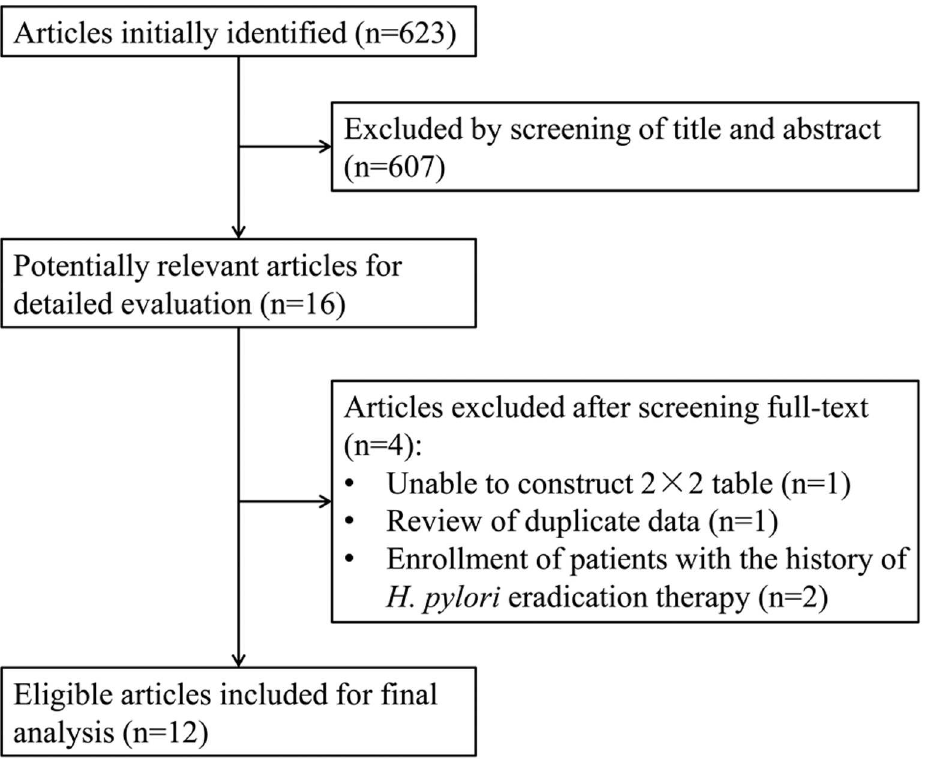
Fig 1. Flow diagram of the study selection process for the meta-analysis. Finally, 18 studies were identifiedfrom the 12